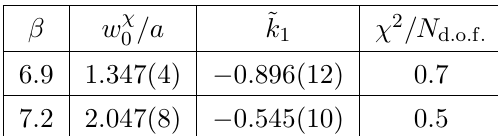
Table 2. Results of the NLO (cid:12)ts for w 0 =a from table 1 and ^ m PS from the combination with table 6. The (cid:12)t uses the (cid:12)ve ensembles with smallest mass to extract the parameters ~ k 1 and w (cid:31) in eq.